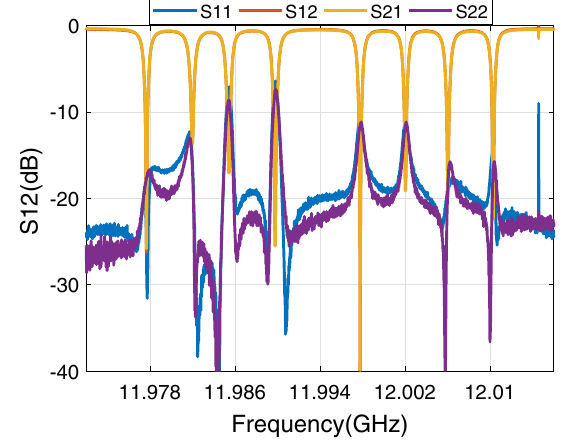
FIG. 4. The frequency spectrum of the CC after tuning. The transmission coefficient of the CC is − 0.46 dB.